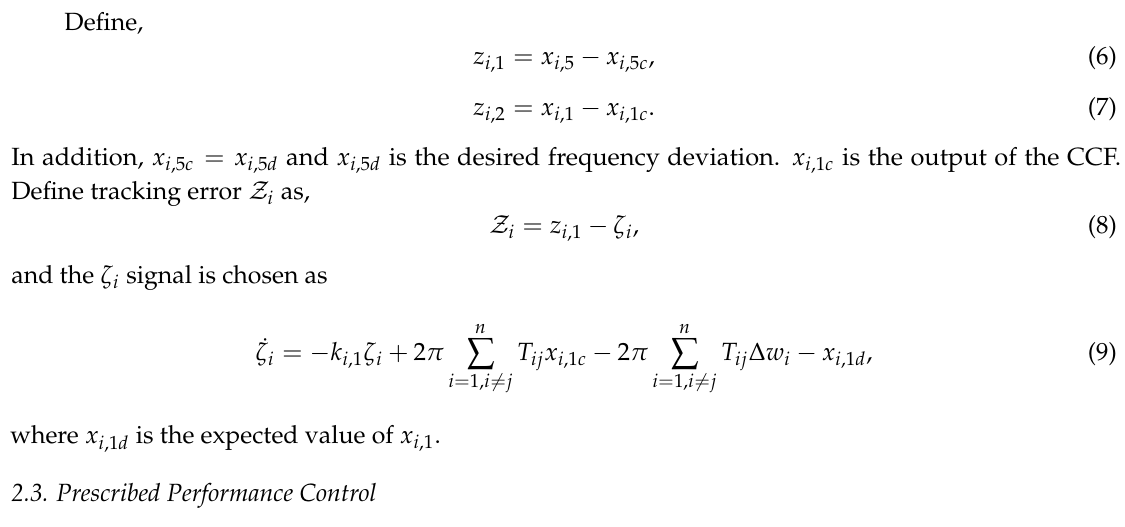
Figure 2. Configuration of the constrained command filter